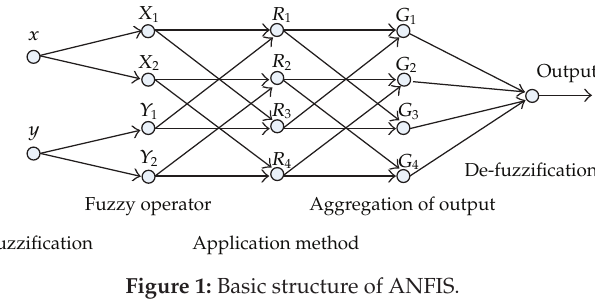
Figure 1: Basic structure of